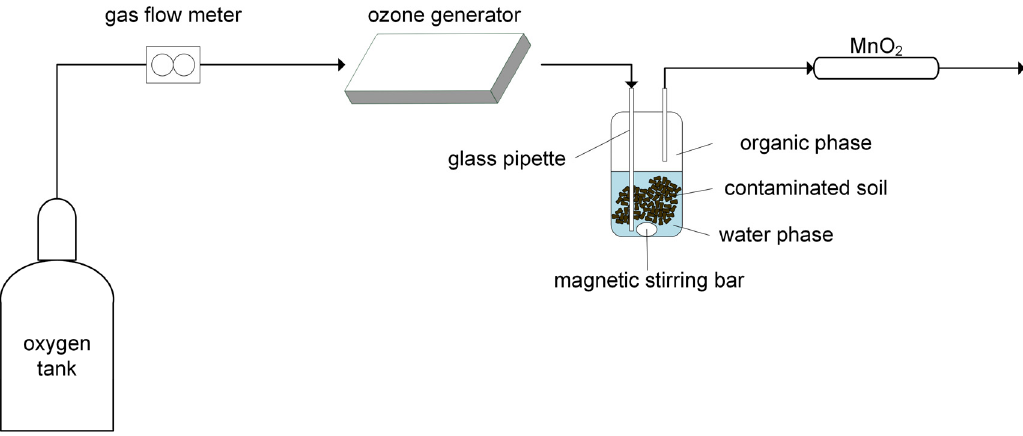
Figure 1. Schematic diagram of the ozonation experimental apparatus.